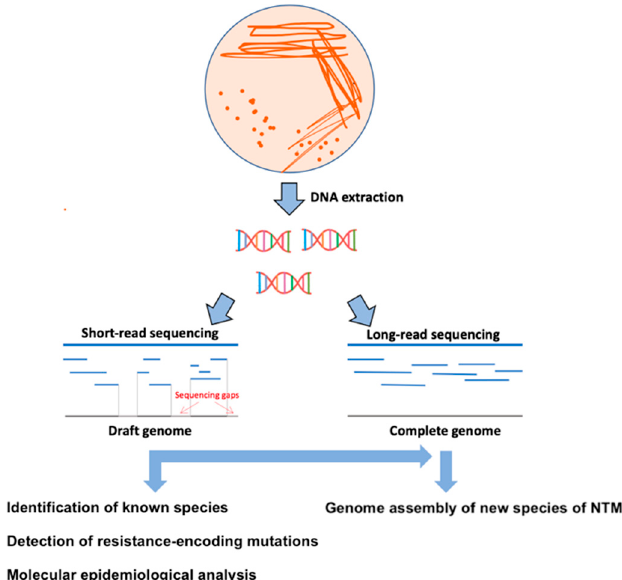
Figure 1. Schematic representation of the WGS methodological procedure. In the first step, DNA is extracted from colonies grown on a solid or liquid culture medium. Subsequently, sequencing libraries are prepared for short- or long-read sequencing. In the last step, the sequencing data are bioinformatically processed for genotyping, identification of resistance patterns, molecular-epidemiology analysis, and assembling of complete genomes of new NTM species.